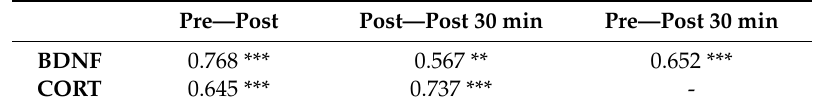
Table 3. Results of correlation analyses performed for BDNF and CORT across the assessment time-points. Pre—Post Post—Post 30 min Pre—Post 30 min BDNF 0.768 *** 0.567 ** 0.652 *** CORT 0.645 *** 0.737 ***